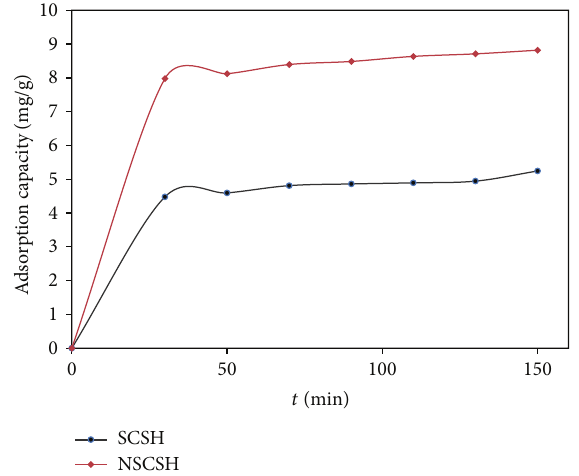
Figure 4: Effect of time on the adsorption of RhB onto SCSH and NSCSH.